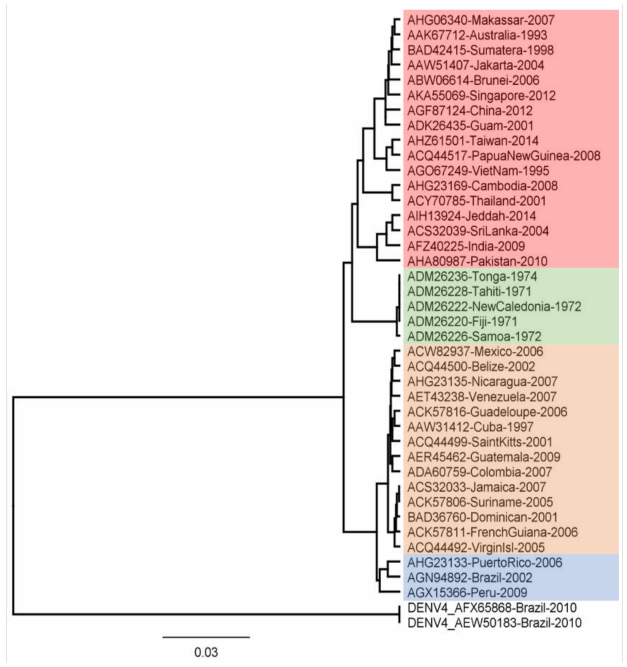
Figure 1. Evolutionary relationships of DENV-2 RNA-Dependent RNA Polymerase Protein. The evolutionary history was inferred using the UPGMA method. The evolutionary distances were computed using the Jukes–Cantor Method. Evolutionary analyses were conducted in Geneious. The DENV-4 sequences, which serve as outgroup, are from Brazil. Table 2. The genotypes of DENV-2 generated from their evolutionary